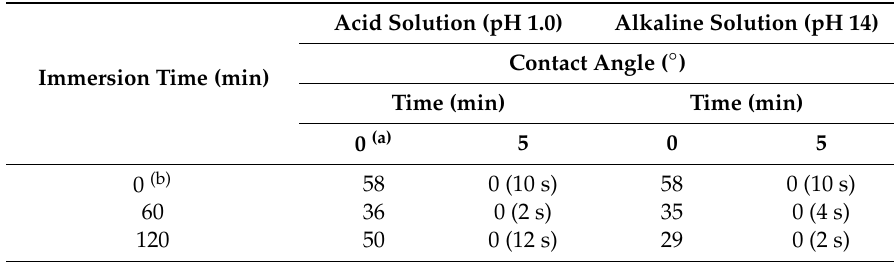
Figure 5. FE-SEM pictures of the parent cotton swatch ( A ) and modified cotton swatch with R F -VMSiO 2 /TAZ nanocomposites ( B ), and EDX mapping micrograph of the fluorine atoms on the cotton surface with R F -VMSiO 2 /TAZ nanocomposites after three cycles of washing with water ( C ). Table 4. Relationship between dodecane contact angle values on the modified cotton fabric and immersion time (min) into the strong acid and alkaline solutions.